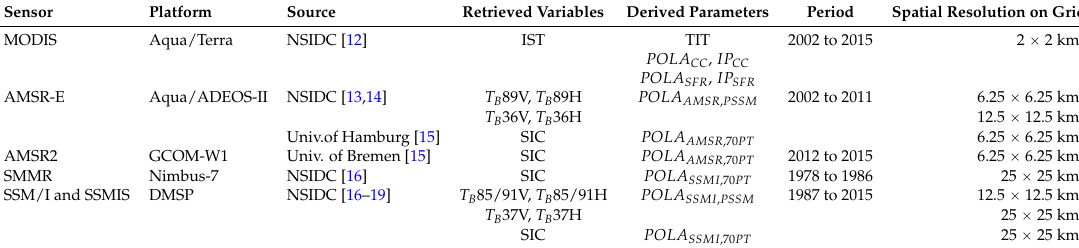
Figure 1. Map of the northern part of Baffin Bay, Nares Strait and Lincoln Sea, all surrounded by Ellesmere Island (Canada) in the west and Greenland in the east. The applied polynya mask is marked in red, enclosing the typical location of the North Water Polynya in wintertime, north of 74 ˝ N and indicating the main study region south of Smith Sound. Bathymetric data by Jakobsson et al. [4] (IBCAO v3.0). Table 1. Overview of sensors, platforms, acquisition sources, raw data and derived parameters, the analyzed period and the effective spatial resolution on the grid for all of the satellite data that are used in this study (IST = ice surface temperature, TIT = thin-ice thickness, T B = brightness temperature, SIC = sea ice concentration, POLA = polynya area, IP = ice production; subscripts of derived parameters denote different methods: 70PT (70% SIC threshold), PSSM (polynya signature simulation method), CC (coverage correction) and SFR (spatial feature reconstruction); see Sections 2.5 and 2.6 for